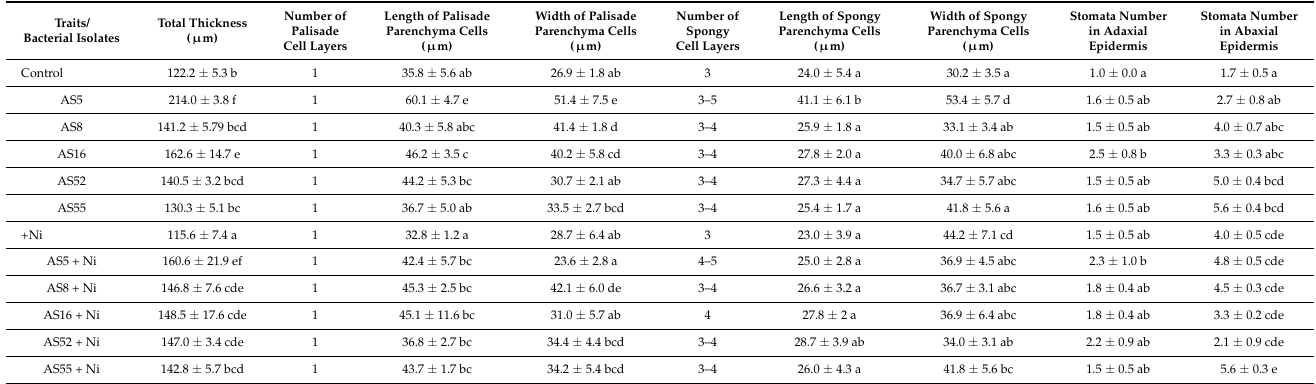
Figure 6. Cross sections of leaves of Arabidopsis non-exposed and exposed to 200 µM Ni, grown under absence or presence of rhizobia. Scale = 50 µm. Table 3. Anatomical traits of leaves of Arabidopsis